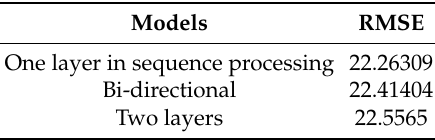
Table 4. Model architecture comparison.